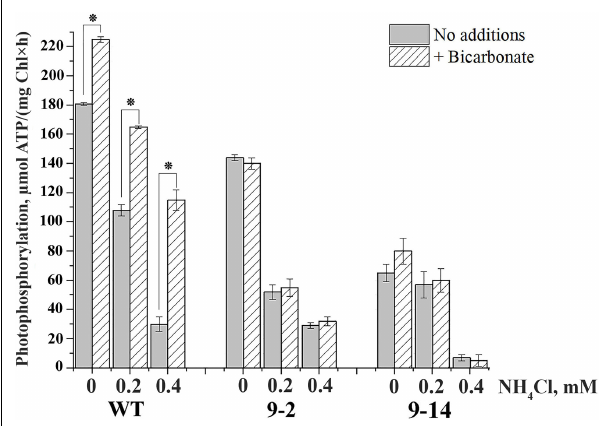
FIGURE 6 | The effect of bicarbonate and NH 4 Cl on the rate of photophosphorylation in thylakoids isolated from leaves of wild-type (WT) Arabidopsis thaliana and two lines of α CA5-KO,“9–2” and “9–14” lines.